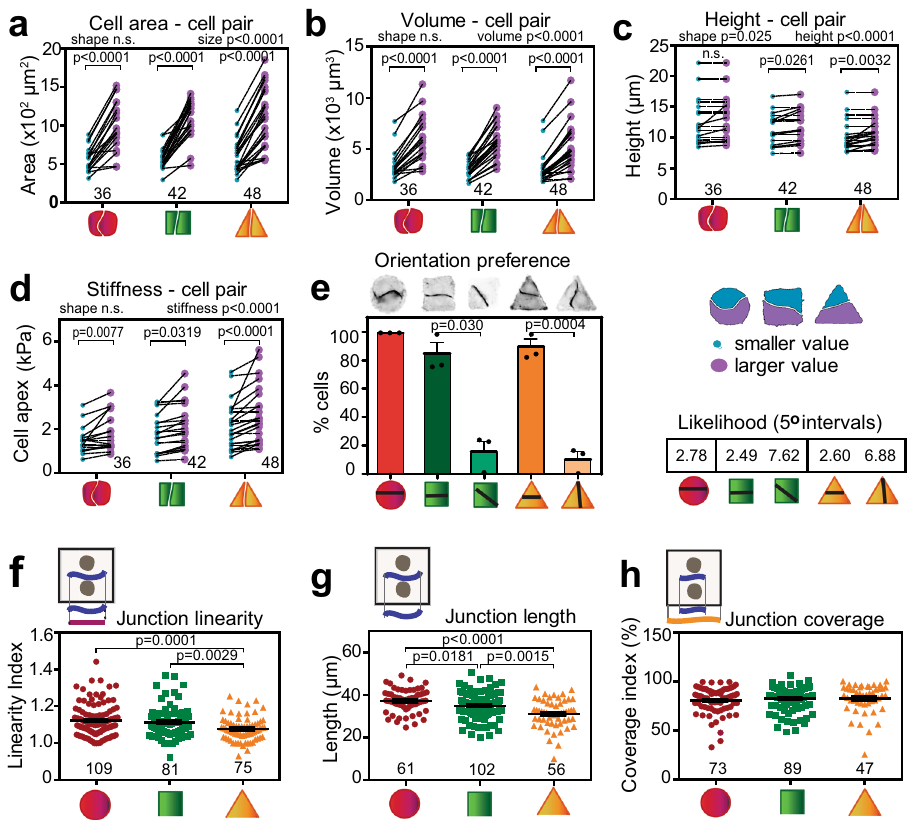
Fig. 3 | Cells sharing a micropattern are unequal. Keratinocytes grown on dif- ferentgeometrieshadtheirbiomechanicalparametersmeasuredineachneighbour of a cell pair and ranked by value. Graphs show the pair-wise distribution with the value of neighbours sharing a micropattern linked by a black line: a cell area; b cell volume; c cell height; d Young ’ s modulus measured at the cell apex. e – h Cells were stained for E-cadherin and F-actin and various parameters were quanti fi ed: the preferenceofjunctionpositioningwithinmicropatternsasapercentageofcellswith a given orientation of cell-cell contacts (orientation preference), and their prob- ability to be found at a 5° angle at the sides or vertices (likelihood, e ); how straight junctions are (linearity index, f ); the length of junctions (junction length, g ); the percentage of the contacting interface area covered with cadherin receptors